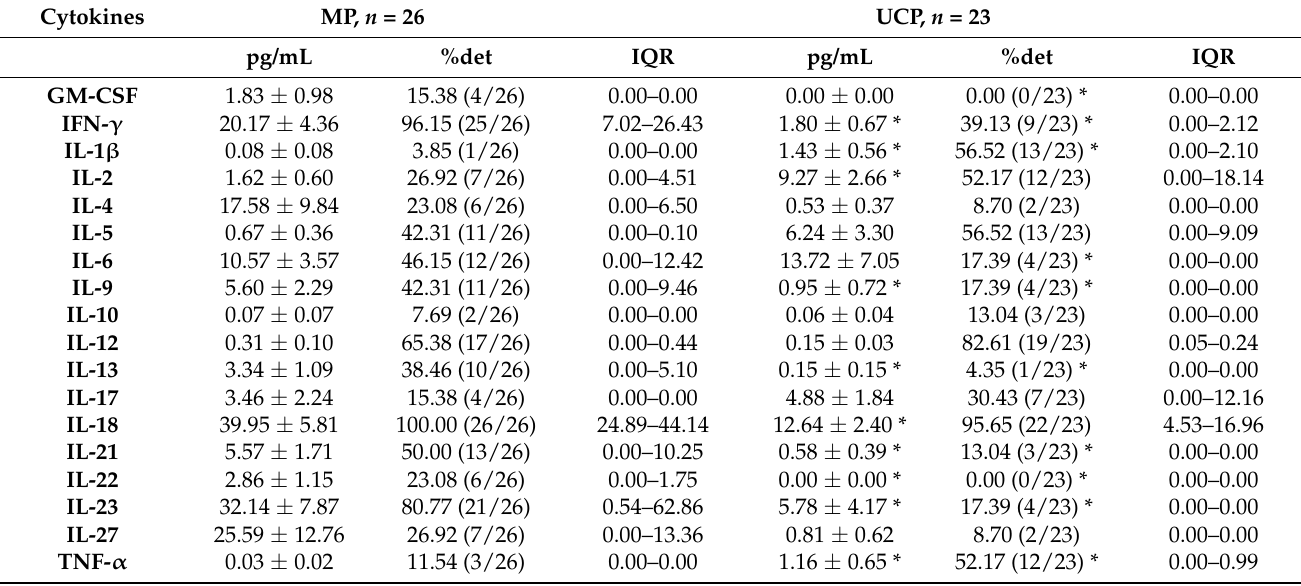
Table 2. Detectability and concentrations of cytokines in maternal and umbilical cord plasma.